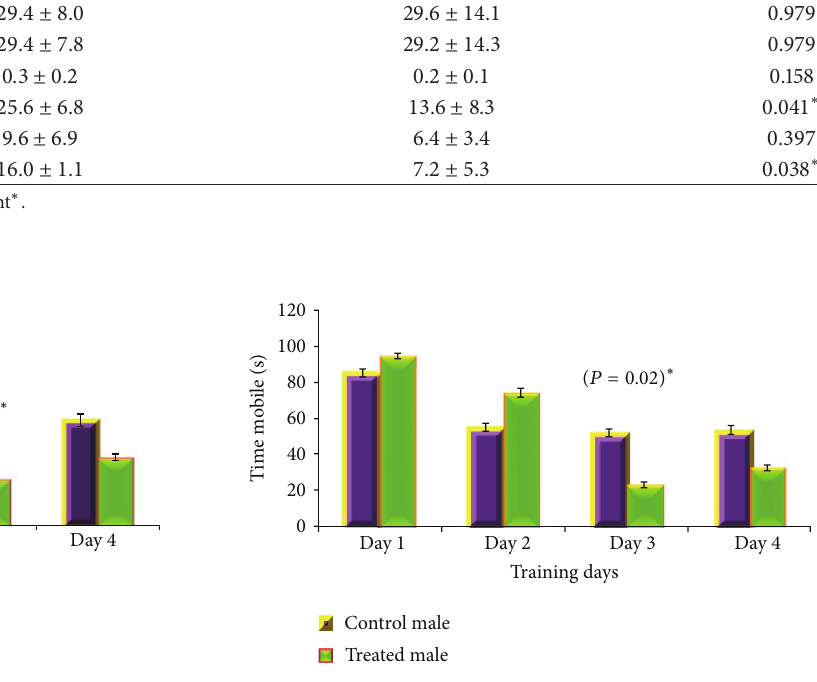
Figure 2: Comparison of total distance (m) travelled by GABA B antagonist and saline treated male albino mouse during acquisition phase of Morris water maze test. Data is expressed as mean ± standard deviation. 𝑃 value indicates the result of 2-sample 𝑡 -test for the specific training day.